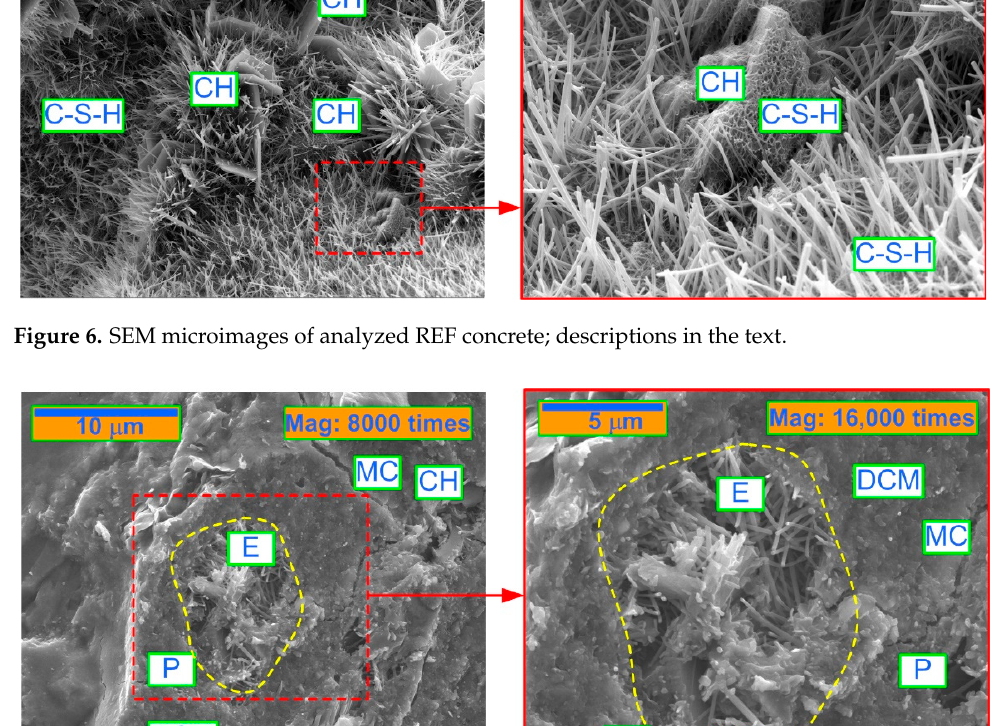
Figure 5. Relative growth rate of compressive strength ( a ) and splitting tensile strength ( b ) of